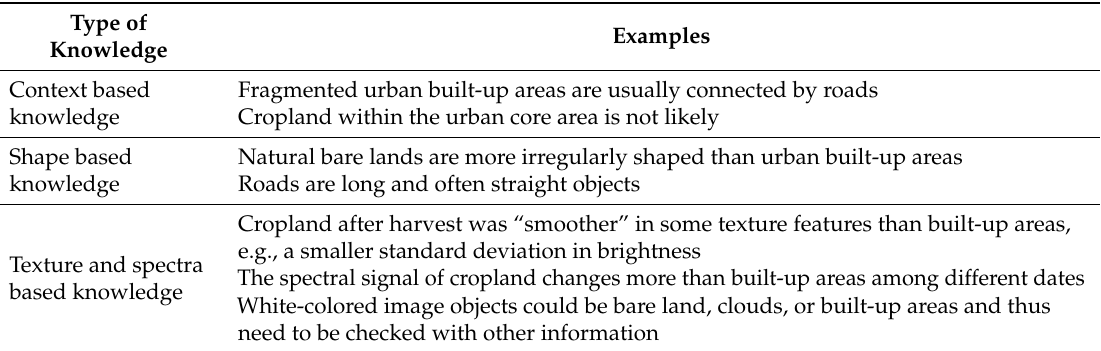
Table 2. Examples of expert knowledge used for locating suspicious images for manual verification and correction. Such knowledge is only available at the image level, but not at the pixel